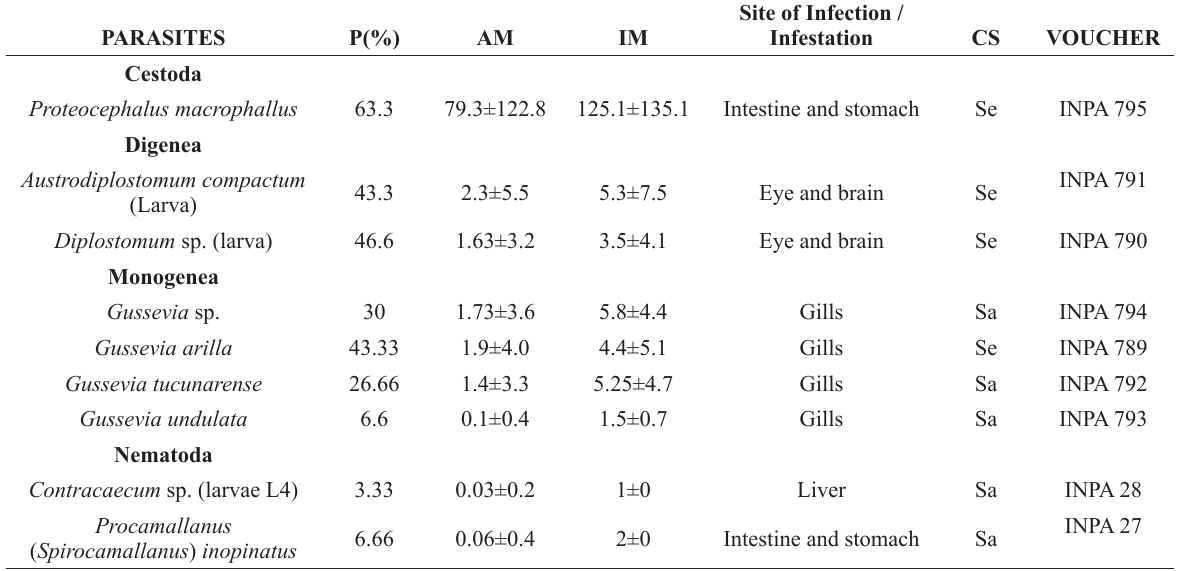
Prevalence (P), abundance (AM), intensity (IM) and community status (CS) of the metazoan parasites of Cichla ocellaris Bloch & Schneider, 1801 collected in the Jacaré-Pepira River, belonging to the Middle Tietê Basin, in the municipality of Ibitinga - SP. Se = secondary species and Sa = satellite species.